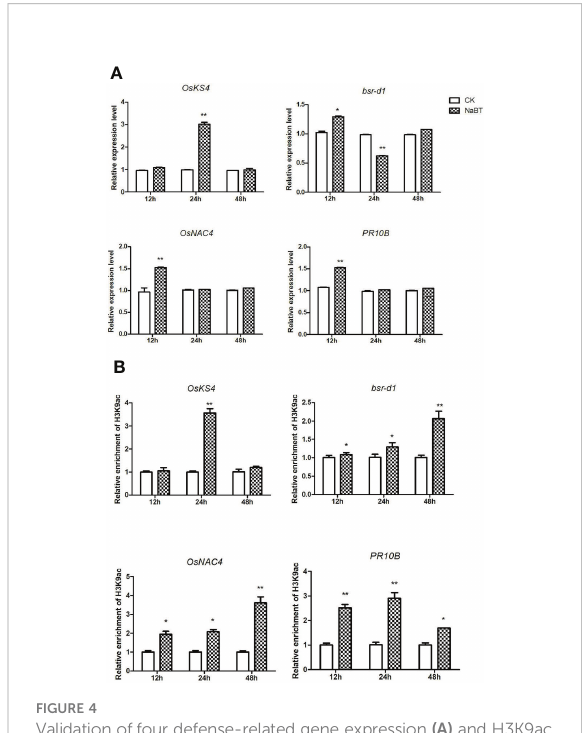
FIGURE 4 Validation offour defense-related gene expression (A) and H3K9ac enrichment (B) on these genes responding to NaBT treatment by RT-qPCR and ChIP-qPCR. The actin gene was used as internal control for RT-qPCR. The input was used as internal control for ChIP -qPCR. Three independent biological repeats were performed for each experiment. (*P< 0.05; **P<